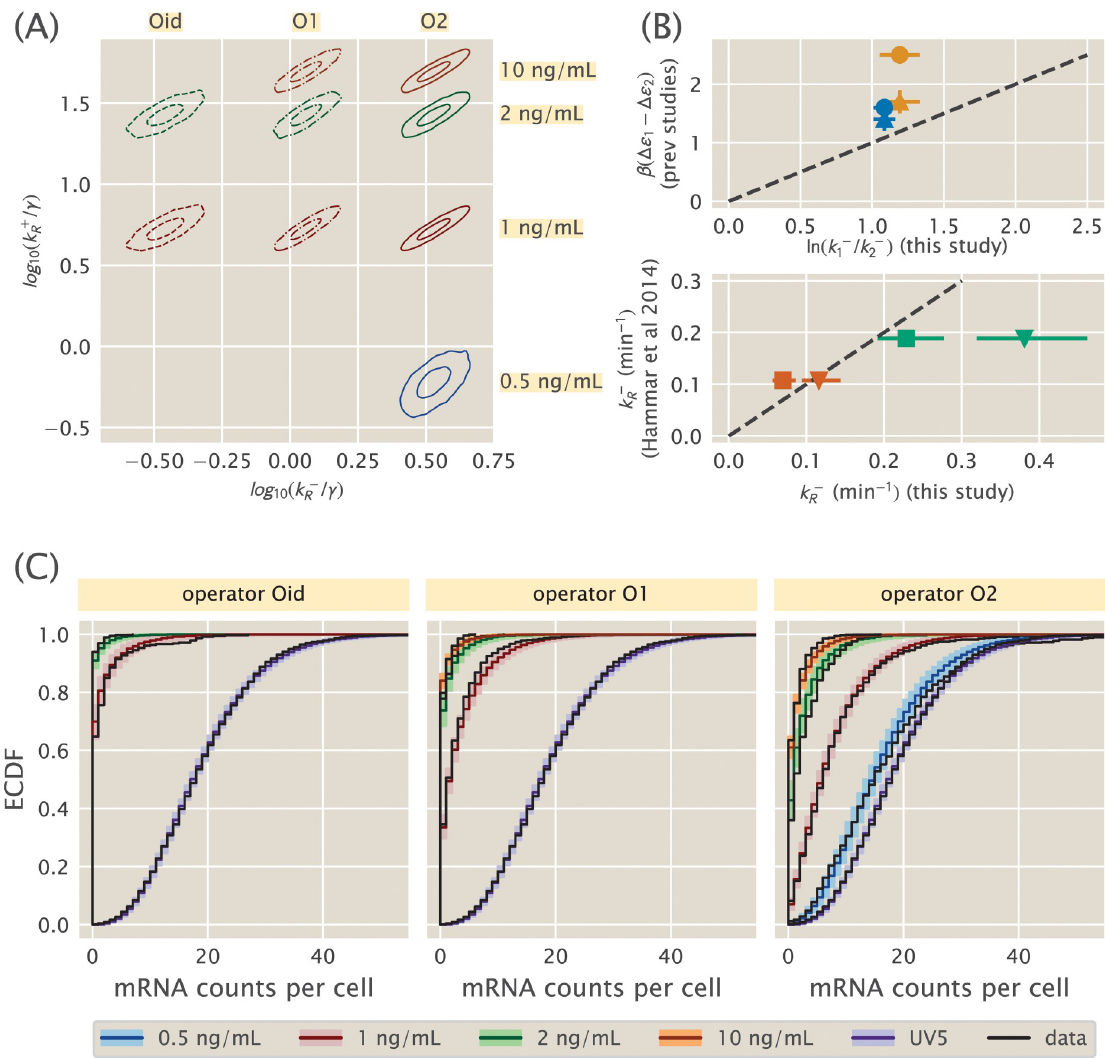
Fig 4. Simple repression parameter inference and comparison. (A) Contours which enclose 50% and 95% of the posterior probability mass are shown for each of several 2D slices of the 9D posterior distribution. The model assumes one unbinding rate for each operator (Oid, O1, O2) and one binding rate for each aTc induction concentration (corresponding to an unknown mean repressor copy number). (B, upper) Ratios of our inferred unbinding rates are compared with operator binding energy differences measured by Garcia and Phillips [41] (triangles) and Razo-Mejia et. al. [43] (circles). Blue glyphs compare O2-O1, while orange compare O1-Oid. Points with perfect agreement would lie on the dotted line. (B, lower) Unbinding rates for O1 (green) and Oid (red) inferred in this work are compared with single-molecule measurements from Hammar et. al. [55]. We plot the comparison assuming illustrative mRNA lifetimes of γ − 1 = 3 min (triangles) or γ − 1 = 5 min (squares). Dotted line is as in upper panel. (C) Theory-experiment comparison are shown for each of the datasets used in the inference of the model in (A). Observed single-molecule mRNA counts data from [33] are plotted as black lines. The median of the randomly generated samples for each condition is plotted as a dark colored line. Lighter colored bands enclose 95% of all samples for a given operator/repressor copy number pair. The unregulated promoter, lacUV5 , is shown with each as a reference.